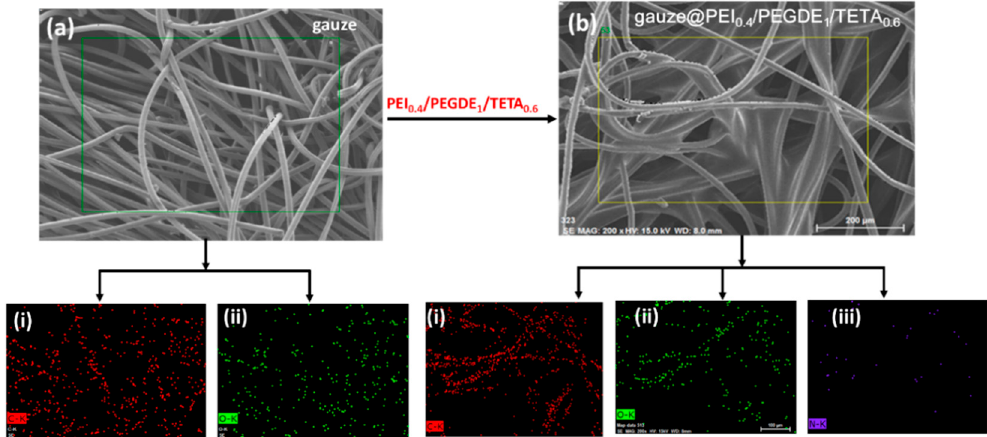
Figure 2. FESEM images of ( a ) pristine gauze and ( b ) gauze@PEI 0.4 /PEGDE 1 /TETA 0.6 . Elemental C, O, and N mapping of the pristine gauze.